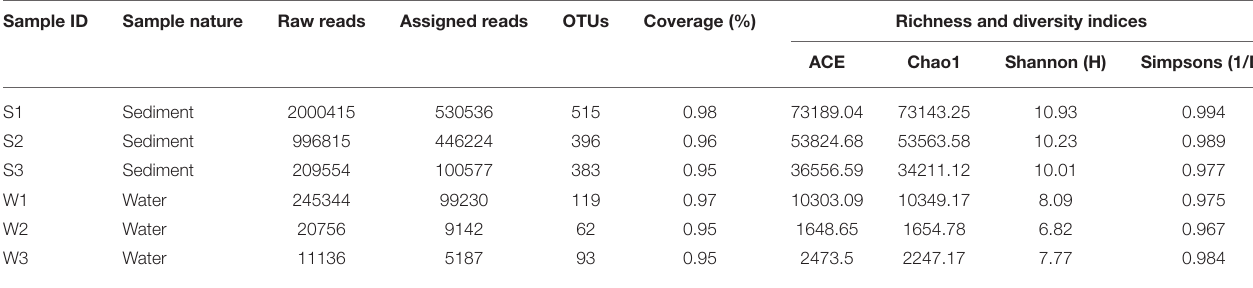
TABLE 2 | Sequence summary and calculation of alpha diversity indices of the sediment and water samples. Sample